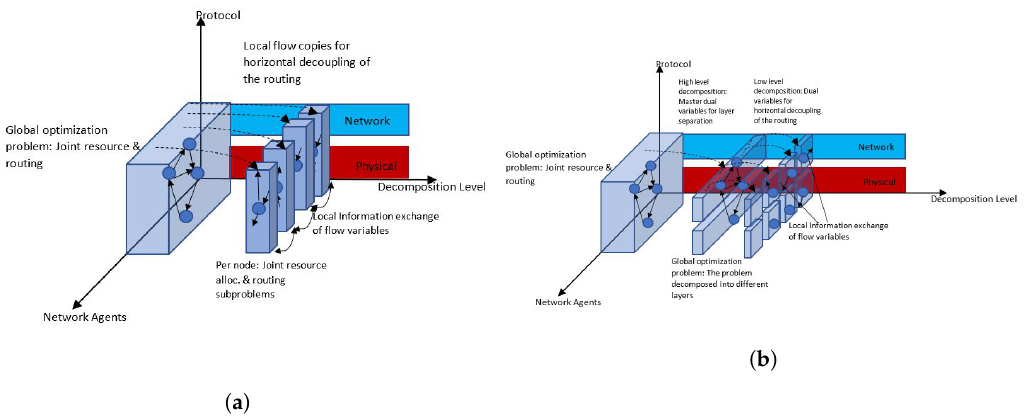
Figure 14. Hierarchical representation of different decomposition steps in [4]. ( a ) Distributed consensus ADMM; ( b ) Dual decomposition